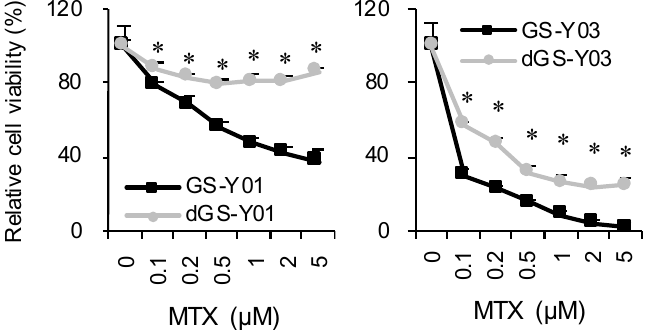
Figure 3. Growth-inhibitory effects of MTX on GSCs and differentiated GSCs. GSCs (GS-Y01, GS-Y03) and differentiated GSCs (dGS-Y01, dGS-Y03) treated with MTX at the indicated concentrations for 3 days were subjected to the WST-8 assay. Their viability relative to control was measured. Values in the graphs represent means + standard deviation from triplicate samples of a representative experiment. Similar results were obtained from two independent biological replicates. * p < 0.05 vs. each concentration MTX-treated GSCs by Student’s t -test. Folate antagonists acquire pharmacological activity after being incorporated by folate carrier protein and metabolized, and folate receptors (FOLRs), reduced folate carrier (RFC- 1/SLC19A1), and proton-coupled folate transporter (PCFT/SLC26A1) are known as folate carrier proteins [14]. Thus, we investigated which folate carrier is expressed in the GSC subsets at the mRNA level. Of the folate carriers, RFC-1/SLC19A1 was strongly expressed in all GSC lines. On the other hand, the expression of FOLR1, 2, and 3 was weak in all GSC subsets, and SLC46A1 was expressed only in GS-Y01 and GS-NCC01